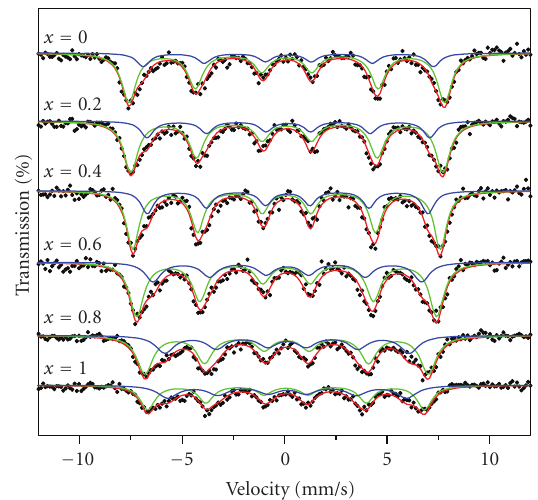
Figure 4: Room temperature M¨ossbauer absorption spectra of